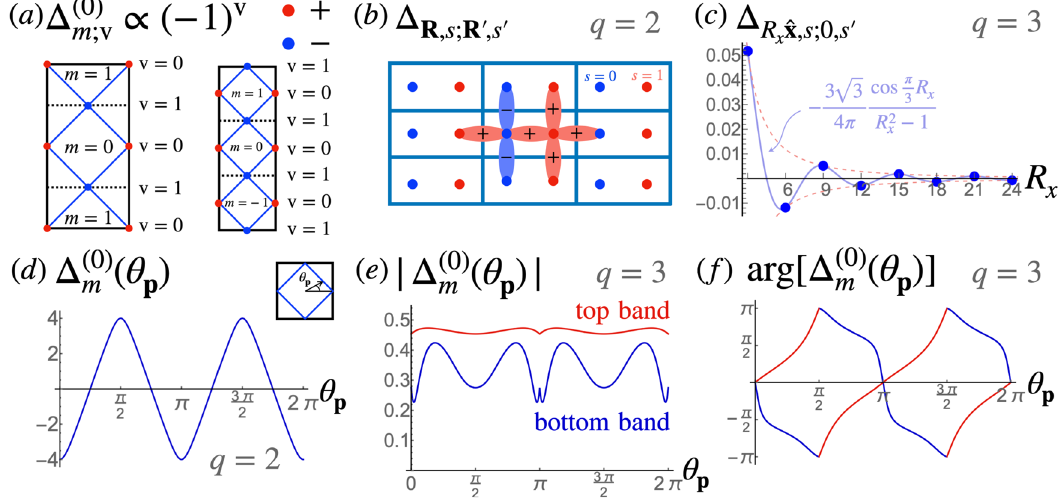
Fig.4|Propertiesofthegapfunctions.a GapfunctionsattheVHSobtainedfrom the Fermi surface within the rMBZ (note that Δ ð ‘ Þ m are equal within each patch m ). the RG analysisfor q =2 atperfectnesting (left) and for q =3 at d ph =0.8 in the top Notethatthegapcrosseszero,indicatingnodesinthefermionicspectrum. e , f The and bottom Hofstadter bands (right). In both cases the gap function changes sign projection onto the Fermi surface of the model gap function for q =3 for the top betweenthetwoVHSsv=0,1.Herewefocusonpairingwithzerototalmomentum (red) and bottom (blue) bands that agrees with the gap function found in the RG ℓ =0,withpairingsfor ℓ ≠ 0determinedbyMTGsymmetries. b Real-spacestructure analysis(coloronline).Notethatthe magnitudeof thegapfunctionnevervanishes ofthegapfunctionfor q =2evenunder ^ T 1 and ^ T 2 andoddunder ^ C 4 ,shownwithina as shown in e , implying that the fermionic spectrum is fully gapped (the sharp single magnetic unit cell (the pattern repeats in all cells). c Pro fi le of the gap features at θ p =0, π are due to the corners of the Fermi surface). The phase of the for q =3 as a function of the horizontal magnetic unit cell projected gap functions, however, winds by±4 π around the Fermi surface in the function Δ R x ^ x , s ; 0, s 0 separation R x between Cooper pairs (with lattice constant a =1). Note that the gap topandbottombandsrespectively,asshownin f ,implyingeach Δ ð ‘ Þ m contributes±2 function oscillates between eachunitcelland decaysas1 = R 2 x atlong distances.See totheChernnumber.Plots( c – e )aregiveninarbitraryunitsasthemagnitudeofthe the Supplementary Material for more details. d The projection onto the Fermi gap function is not determined within the weak-coupling theory. surface of the gap function for q =2 shown in b as a function of the angle θ p along